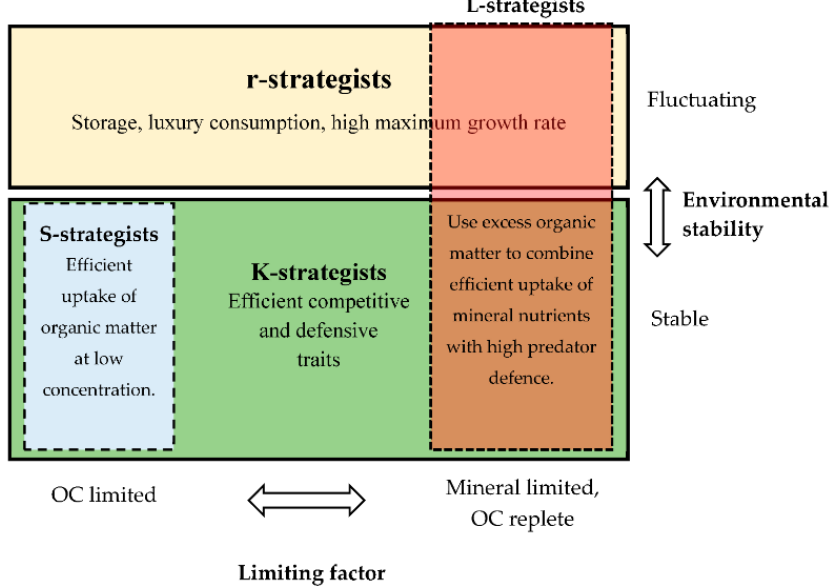
Figure 2. Summary of strategies discussed (S (blue), L (red), r (yellow), and K (green)), arranged in the two dimensions of ( y -axis) environmental disturbances and ( x -axis) growth rate limitation by mineral nutrient vs. organic C (OC). Fluctuating environments select for r-strategists with characteristic traits such as high maximum growth rate, rapid luxury consumption, and storage of presently non-limiting nutrients. Stable environments create climax communities consisting of K-strategists, where competitive ability at low nutrient concentrations and defense mechanisms against predation and viral infections are assumed to be important traits. In this scheme, the S-strategists, with their “streamlining” strategy, dominate when OC/energy is limiting. L-strategists dominate when there is sufficient non-limiting OC to allow a reduction in their competition-defense trade-off below that of the S-strategists. As the S-strategy is suggested to involve storage of OC, they have traits classifying them as both r- and K-strategists.